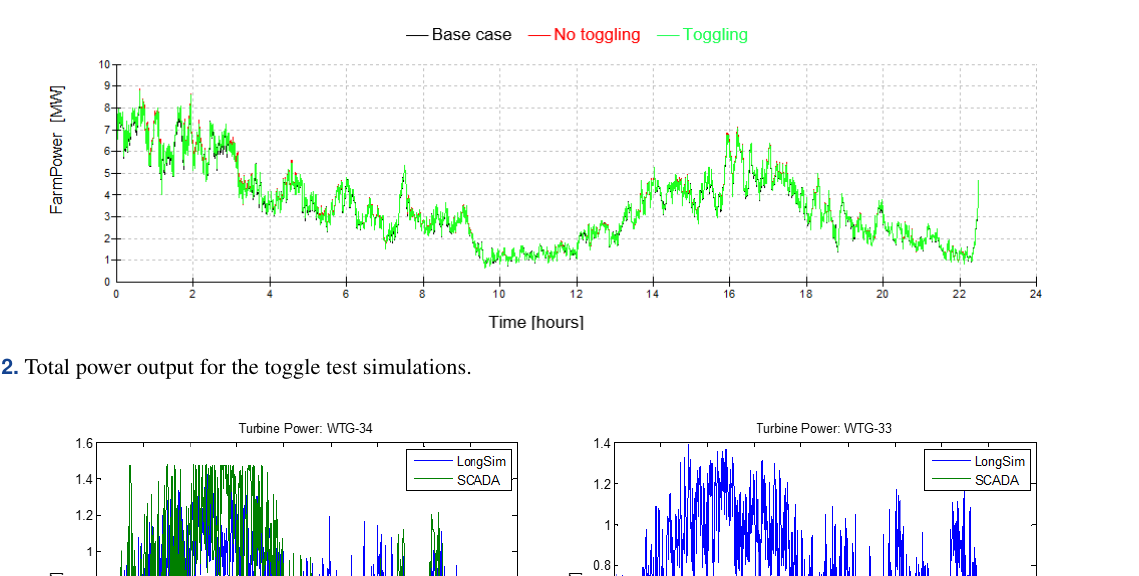
Figure 11. Induction control setpoints showing controller toggling (turbine no. 37 illustrated).